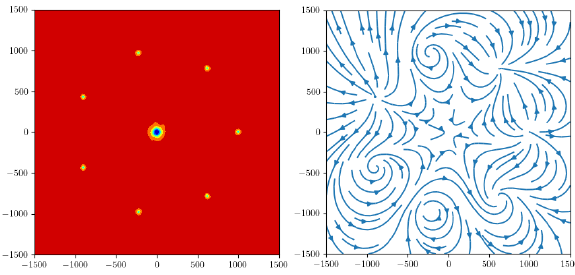
Figure 2. Transverse sections in the ( x ,y ) plane showing the in- tensity (left) and phase gradient lines (right) of a vortex soliton structure with a central l = 3 singularity surrounded by an hep- tagonal regular distribution of negative single-charged vortices ( Z 7